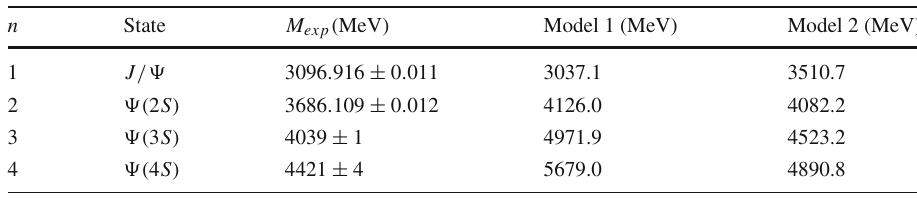
for the Bottomonium S-wave resonances. Experimental results are from PDG [67]